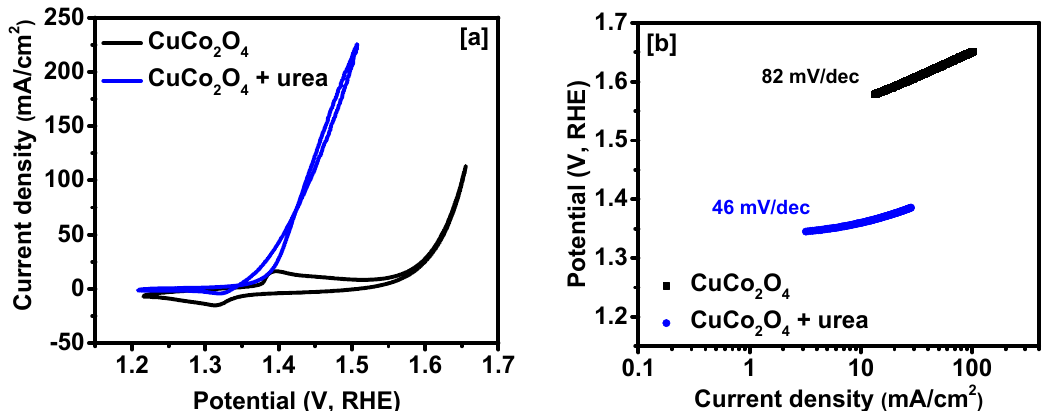
Figure 5. ( a ) Cyclic voltammetry curves in 1 M KOH with and without 0.33 M urea, and ( b ) corresponding Tafel slopes.